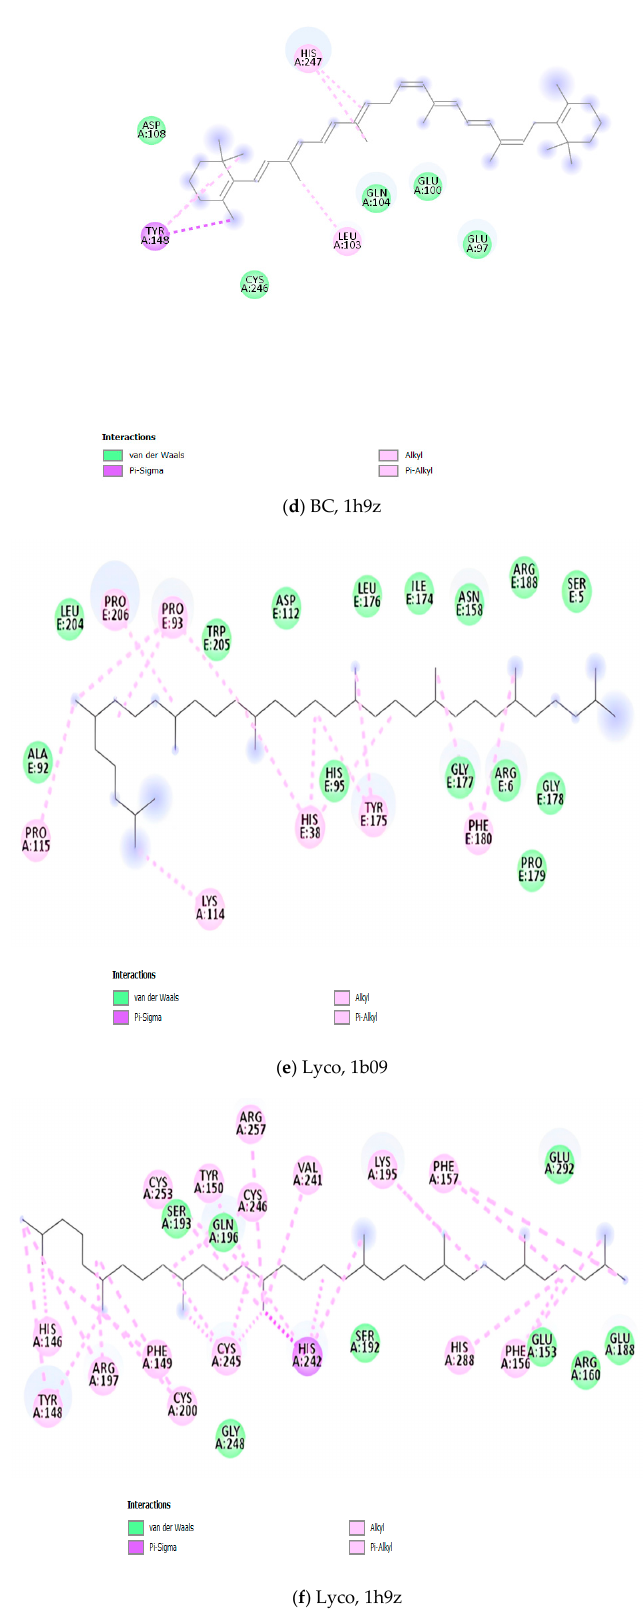
Figure 3. 2D Protein-ligand binding interactions map for Vitamin C ( a , b ), β -carotene ( c , d ), and lycopene ( e , f ) docked with proteins. The compounds present in the beverage are well known for their therapeutic effects. High levels of CRP indicate inflammation due to many unwanted conditions. It is also an important part of innate immunity in our body as it activates macrophages and oxidative stress. It is the indicator of inflammation in our body, and therefore, the elevated levels of CRP proteins indicate the risk for cardiovascular problems and other infections from diseases such as cancer [24,25]. On the other hand, the protein HSA is synthesized in the liver and found in the blood. It is also associated with anti-inflammatory properties in the body and lower levels of HSA indicate the risk of developing cardiovascular diseases. Apart from carrying endogenous and exogenous substances, it is an important antioxidant of blood and helps in maintaining blood pH levels [9]. As evident in the present study, the bioactive compounds present in the beverages, mainly vitamin C, β - carotene, and lycopene, are significantly interacting with the amino acids of the target protein as these compounds perfectly fit at the binding site of the proteins. This suggests that the interaction of these compounds has decreased the activity of CRP and increased the antioxidant efficiency of HSA, therefore, beverages reported in this study possess therapeutic potential. 3.3. Effect of Thermal Treatment on the Quality Characteristics of Beverage The TSS and total sugars of tomato-based pineapple beverage samples treated at different temperatures did not show any significant ( p ≤ 0.05) changes. The TSS and total sugars of beverage samples untreated and treated at 70–90 °C ranged from 14.50 to 14.80% and 12.40 to 12.48 g, respectively (Figure 4). These results were found to be similar to the inferences of the study conducted by Mehta , et al. [26] and Caminiti , et al. [27], where no significant ( p ≤ 0.05) changes were observed in TSS values of thermally processed tomato- based beverages. Ordóñez-Santos , et al. [28] stated that this non-significant ( p ≤ 0.05) change could be due to the intensity or energy applied, which resulted in no effect on the physiochemical properties of the high molecular weight structures.